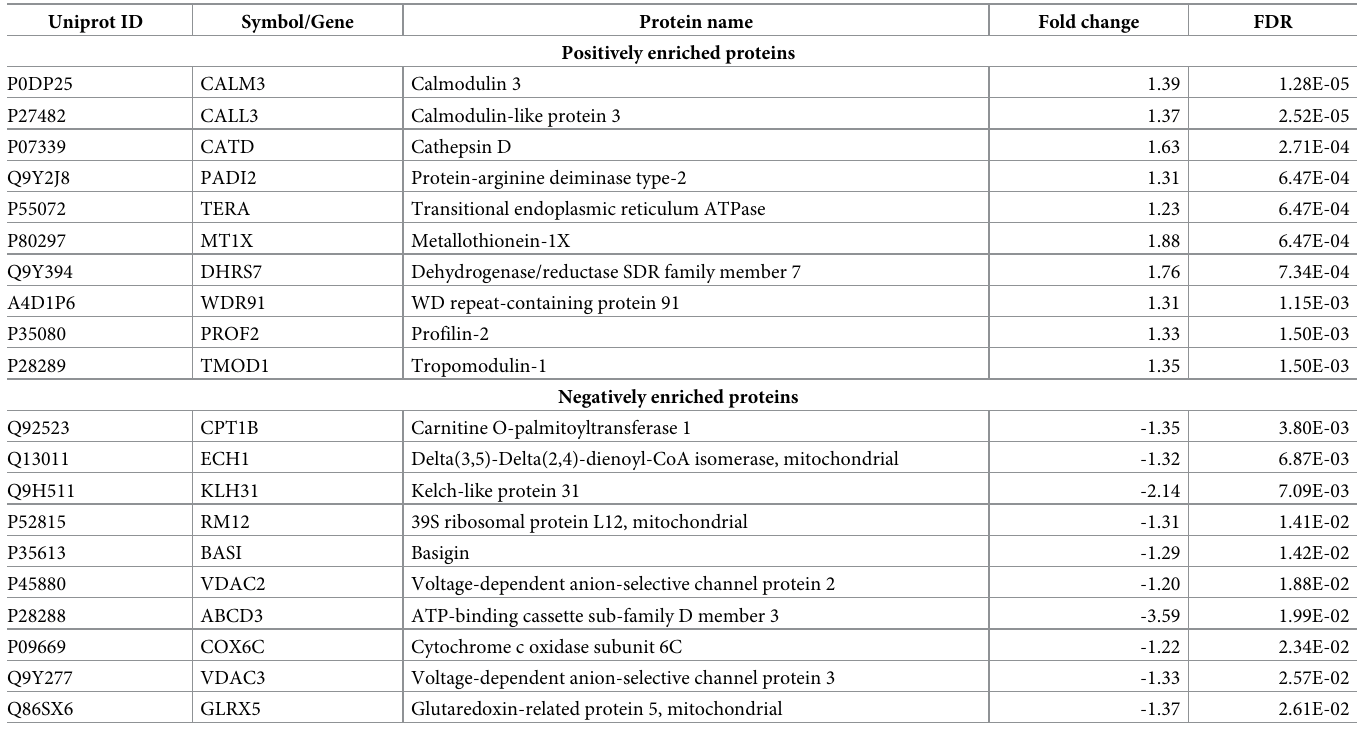
Table 2. Ten most reliably changed (lowest FDR) positively and negatively enriched proteins after 14 d of immobilization compared to baseline. Uniprot